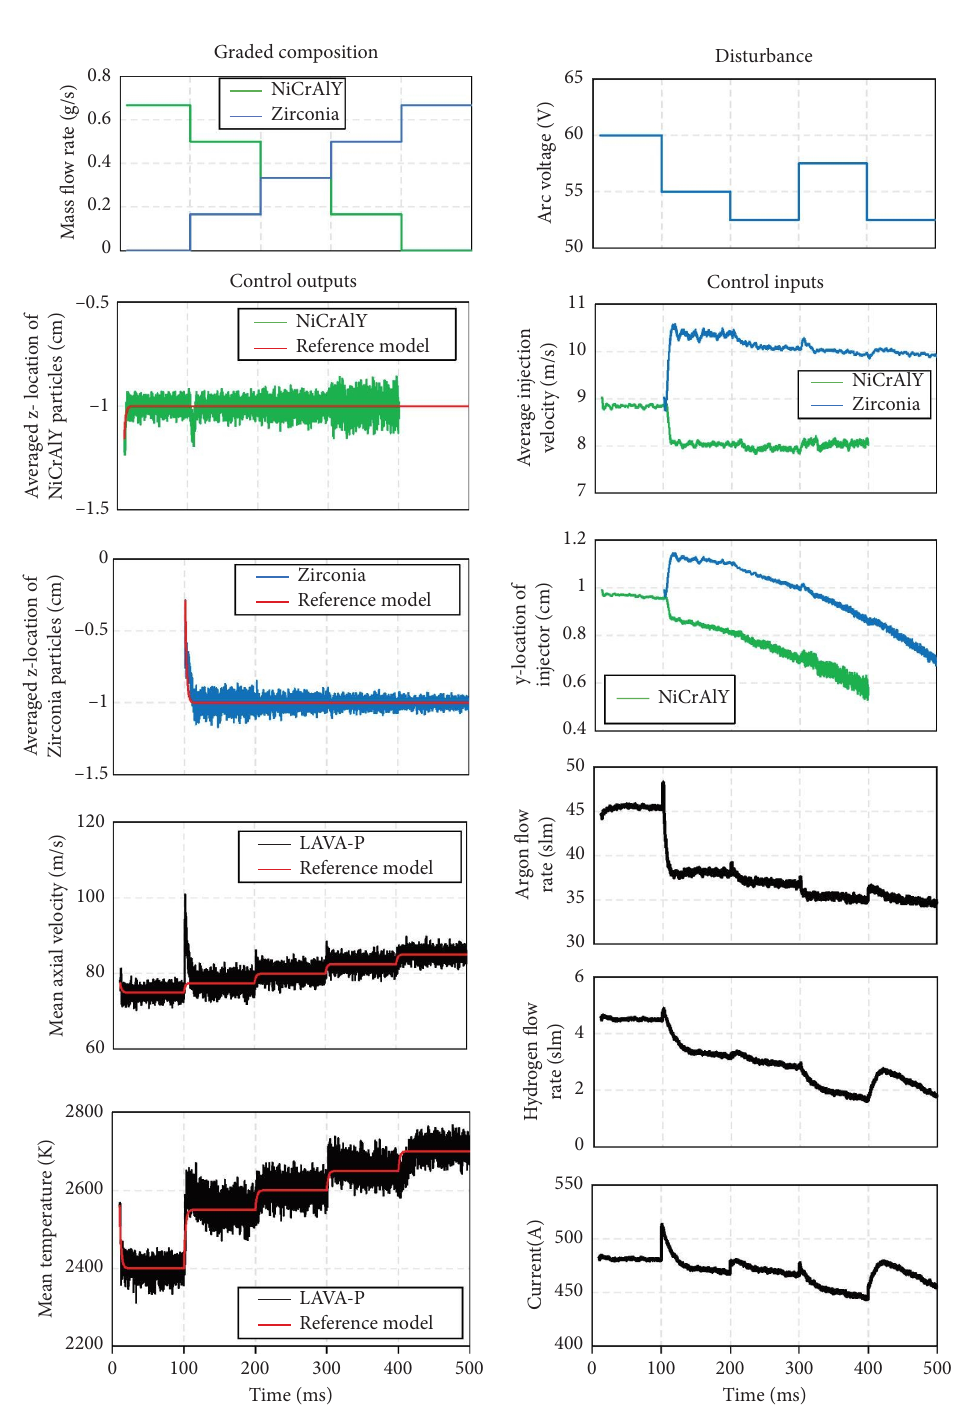
Figure 13: For the desired graded composition of the coating exhibited in row 1 in column 1 under the disturbance shown in row 1 in column 2, the adaptive tracking performance of the measured outputs to the desired responses of the reference model (in red) is depicted from row 2 to row 5 in column 1 using the adaptive process controller by adjusting the control inputs shown from row 2 to row 6 in column